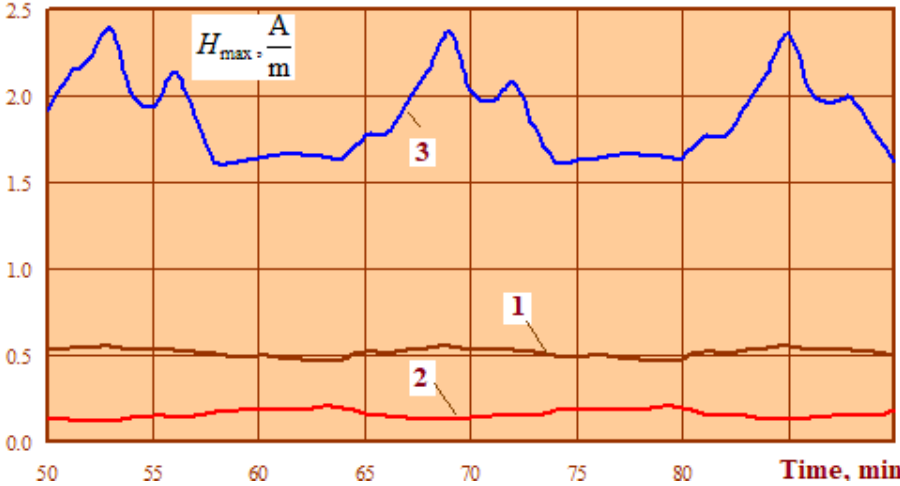
Figure 13. Magnetic field (MF) strength at a height of 1.8 m at the beginning of the transmission line 5—callout numbers correspond to those in Figure 6.